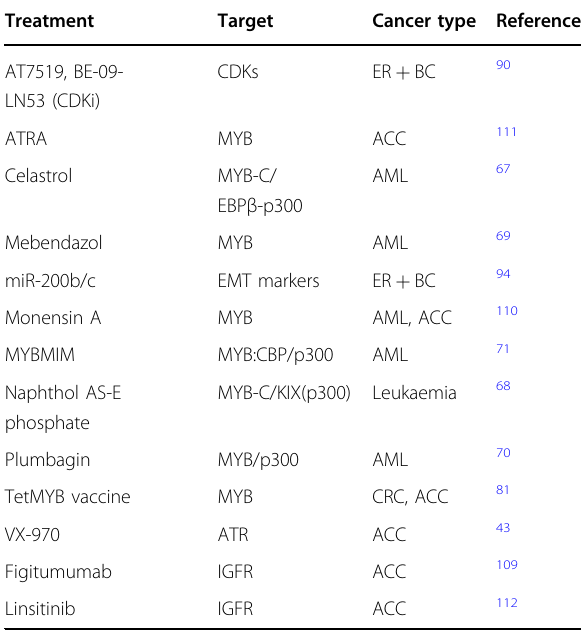
Table 2 Preclinical and clinical therapeutic strategies based on inhibition of MYB or actionable MYB- target